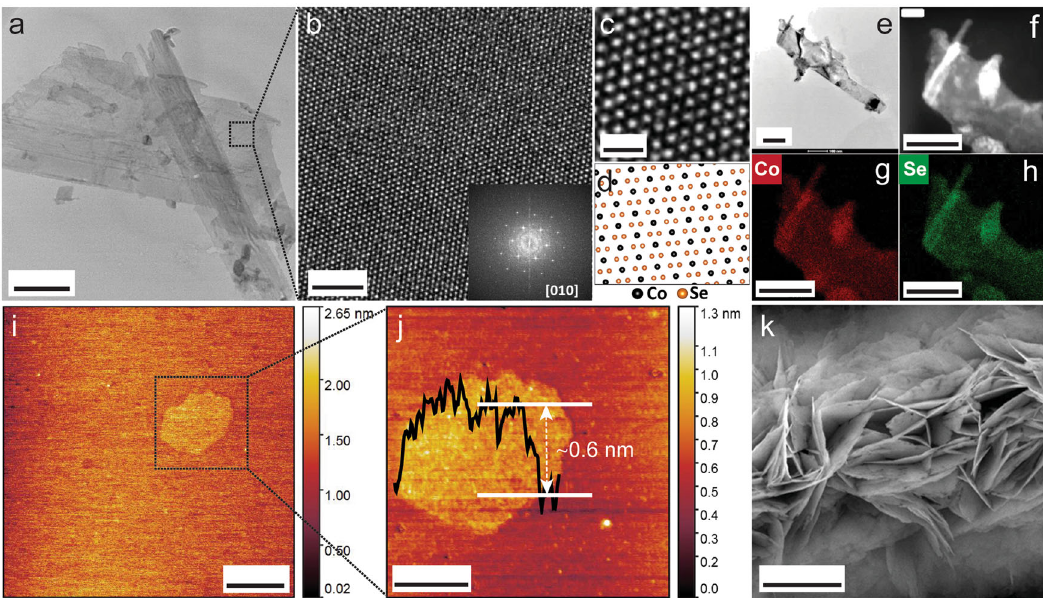
Fig. 1 Characterization of o-CoSe 2 nano fl akes. a Low-magni fi cation TEM image of thin layers of o-CoSe 2 . The scale bar indicates 100 nm. b HR-TEM image of the o-CoSe 2 lattice structure from the area marked with a square in a , with a scale bar of 2 nm; the inset shows the FFT pattern of the image. c A Fourier- fi ltered image of o-CoSe 2 (scale bar 0.5 nm). d Schematic model of o-CoSe 2 where black balls indicate Co atoms and orange balls indicate Se atoms. e , f Low-magni fi cation TEM and HAADF-STEM images of o-CoSe 2, respectively (scale bars 100 nm). g , h EDS elemental mapping of Co: red and Se: green, respectively (scale bars 100 nm). i , j AFM images of the o-CoSe 2 monolayer (scale bars 1 μ m and 500 nm, respectively). k SEM image of vertically oriented o-CoSe 2 nano fl akes (scale bar 5 μ